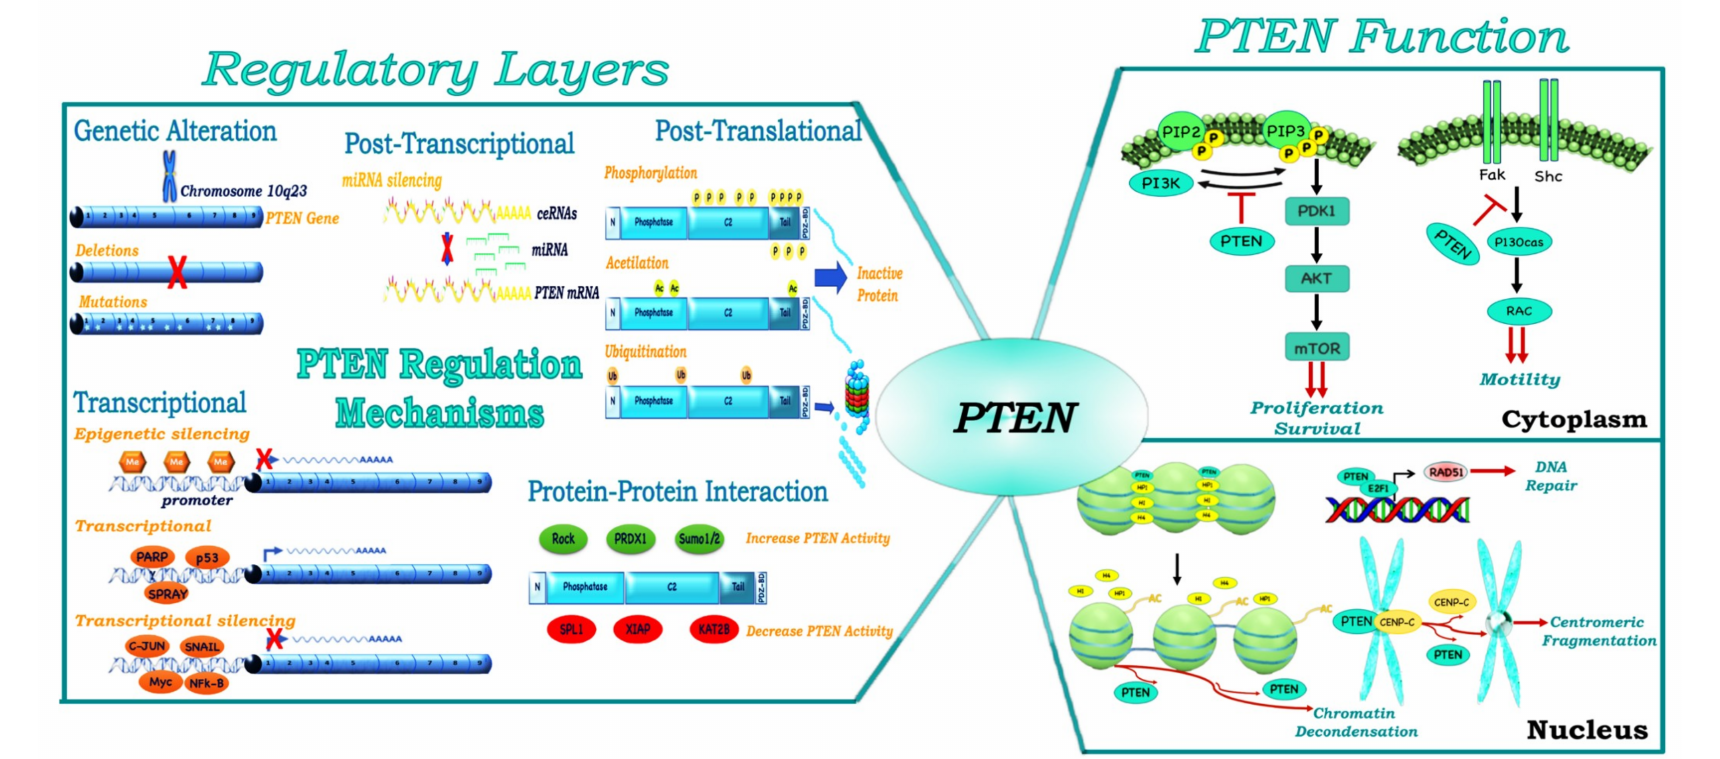
Figure 2. PTEN protein regulation and function. PTEN protein expression is regulated by genomic (mutation and deletions), transcriptional (epigenetic mechanisms and transcription factors), post-transcriptional (miRNAs, PTEN pseudogene), post-translational mechanisms (phosphorylation, acetylation, ubiquitination, etc.) and protein–protein interaction. PTEN performs multiple cellular functions, at least in part determined by its subcellular localization. In the cytoplasm, PTEN dephosphorylates PhosphatidylInositol-3,4,5-trisPhosphate (PIP3), decreasing PI3K activity and several proteins such as focal adhesion kinase (FAK) or Src-Homology/Collagen (SHC), to regulate different signal networks. The nuclear PTEN activities include the regulation of genomic stability, gene expression, DNA repair mechanisms and centromeric